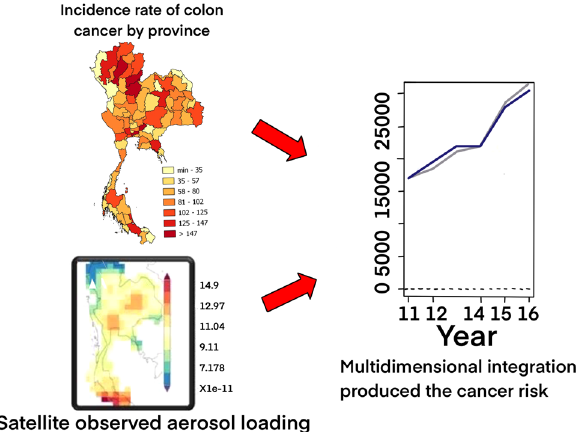
Figure 1. An investigation on spatial and temporal associations for the relative risk of accumulated air quality and incidence rates of colon cancer. (The maps were generated by QGIS software: a free and open source geographic information system, https